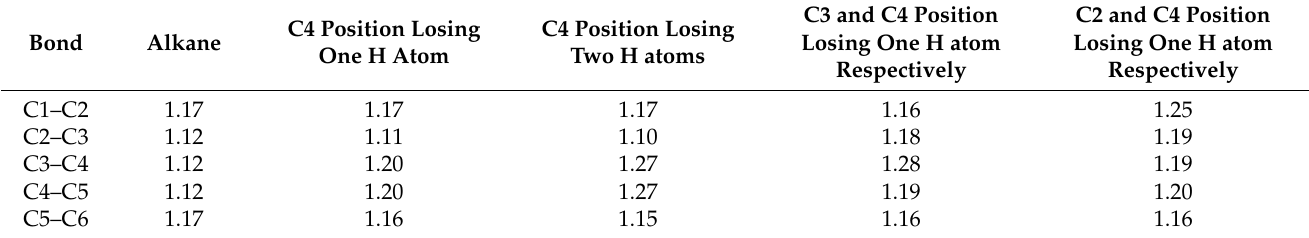
Table 1. Fuzzy bond order of different alkane radicals (the unit is